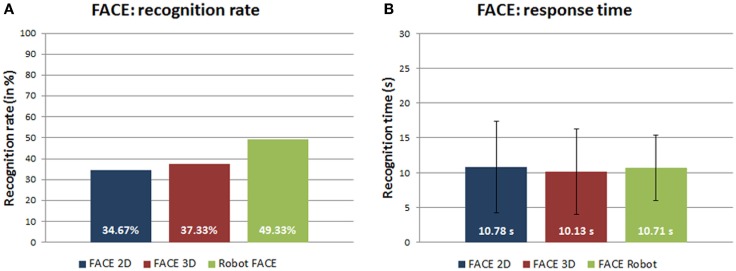
(A) Recognition rates (in percentage) and (B) response time (in seconds) of robot 2D photos, robot 3D models, and robot FACE expressions.